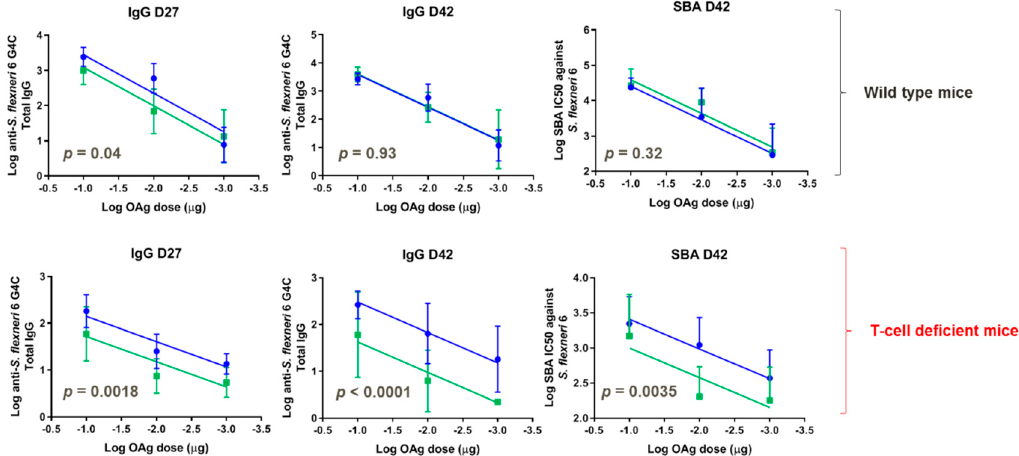
Figure 7. S. flexneri 6 GMMA with MMM OAg and LMM OAg (blue) or LMM OAg only (green) compared in mice. Eight wild-type and eight T-cell deficient mice per group were subcutaneously immunized at days 0 and 28, with di ff erent OAg doses without Alhydrogel. Each curve represents log-transformed doses on the abscissa and the log-transformed ELISA units or SBA titers on the ordinate. The parallelism of the lines was tested by comparison of the slopes, which resulted in not-significant di ff erence. Subsequently, the Y -intercept of the curves obtained for the two GMMA were compared and the p -value is reported in each graph.